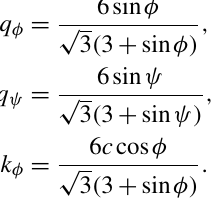
Figure 1. Drucker–Prager yield surface in the ( σ m – τ ) space. The yield surface is made of a shear line segment (in red) and a tensile line segment (in